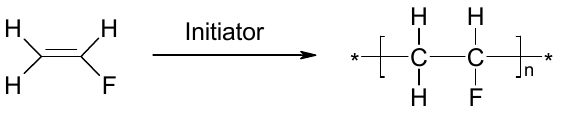
Figure 4. The polymerization of